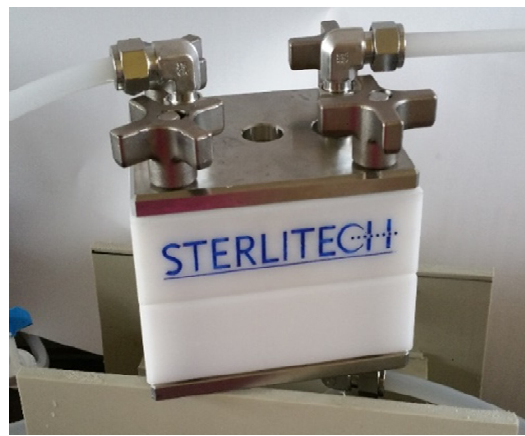
Figure 1. CF042D-FO Sterlitech laboratory module.